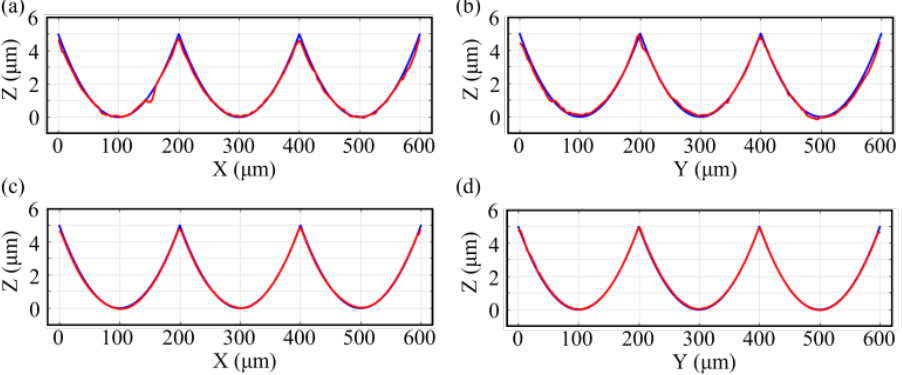
Figure 7. ( a ) A photo of the microlens array machined by CS and HFUVAS, ( b , c ) measured 3D structure of the machined microlens array. Figure 8 shows the results of the form deviation between the designed profile and the measured profile for the microlens array machined by CS and HFUVAS. The results show that the measured profile of the microlens array machined by CS had a large deviation from the corresponding designed profile. The measured profiles were not smooth with surface variation as compared with the designed one. In contrast, for the form deviation between the target profile and the measured profile of the microlens array machined by HFUVAS, the measured profiles were smoother as compared with those machined by CS, and the form deviation between the measured profile and the designed profile is significantly reduced. As a result, it is found that HFUVAS can improve surface finish and reduce form deviation as compared with CS.